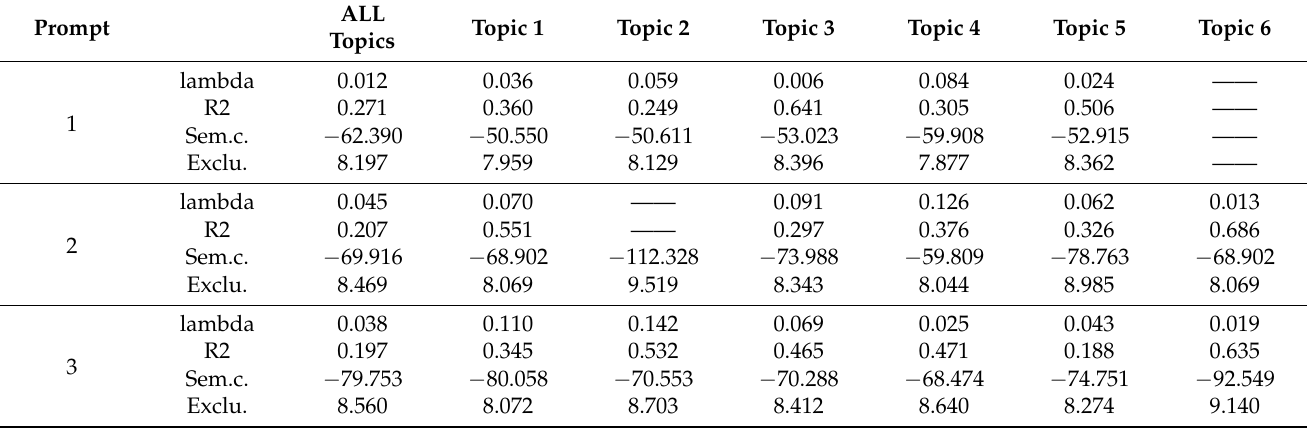
Table 3. R-square for the lasso analysis and the topic quality diagnostic statistics (semantic coherence and exclusivity) cross